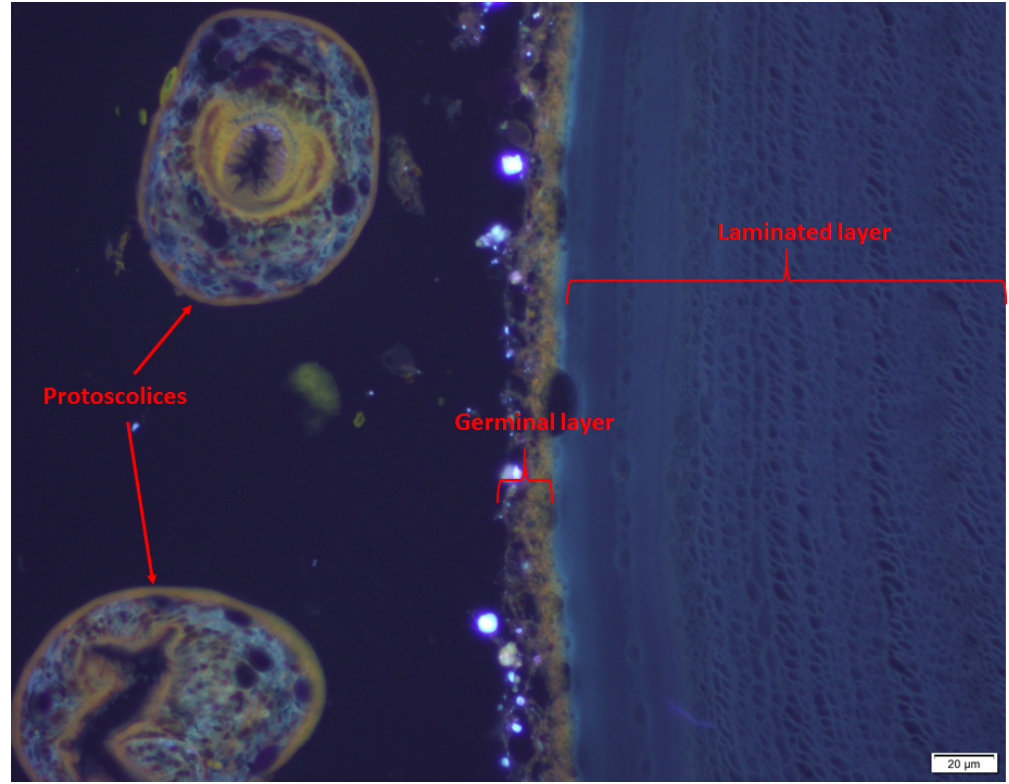
Figure 4. Showing protoscolices, germinal layer and laminated layer’ photo credit: C.